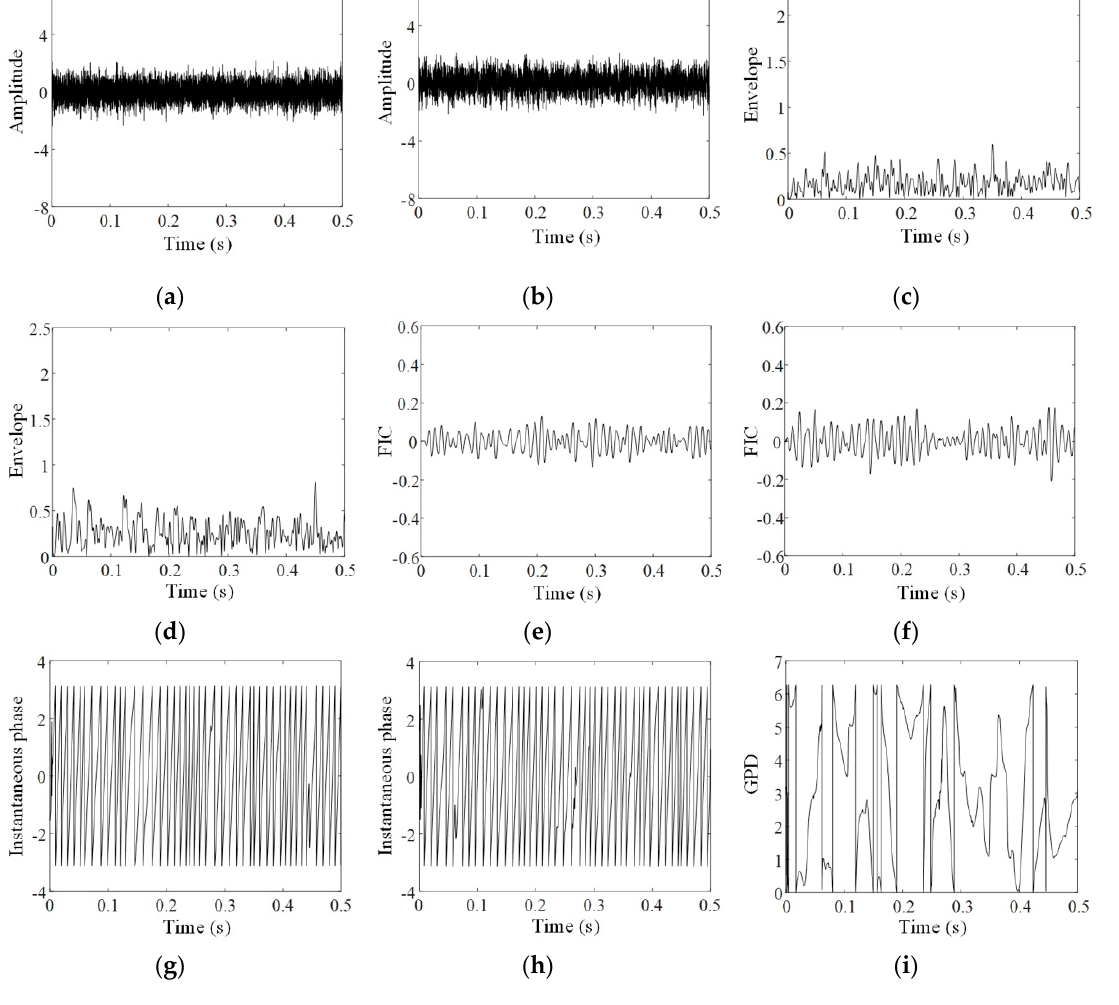
Figure 4. PSA of the 60th minute vibration signals: ( a ) horizontal signal; ( b ) vertical signal; ( c ) envelope of horizontal signal; ( d ) envelope of vertical signal; ( e ) FIC of horizontal signal; ( f ) FIC of vertical signal; ( g ) instantaneous phase of horizontal FIC; ( h ) instantaneous phase of vertical FIC; ( i ) generalized phase difference (GPD) of vibration signals.